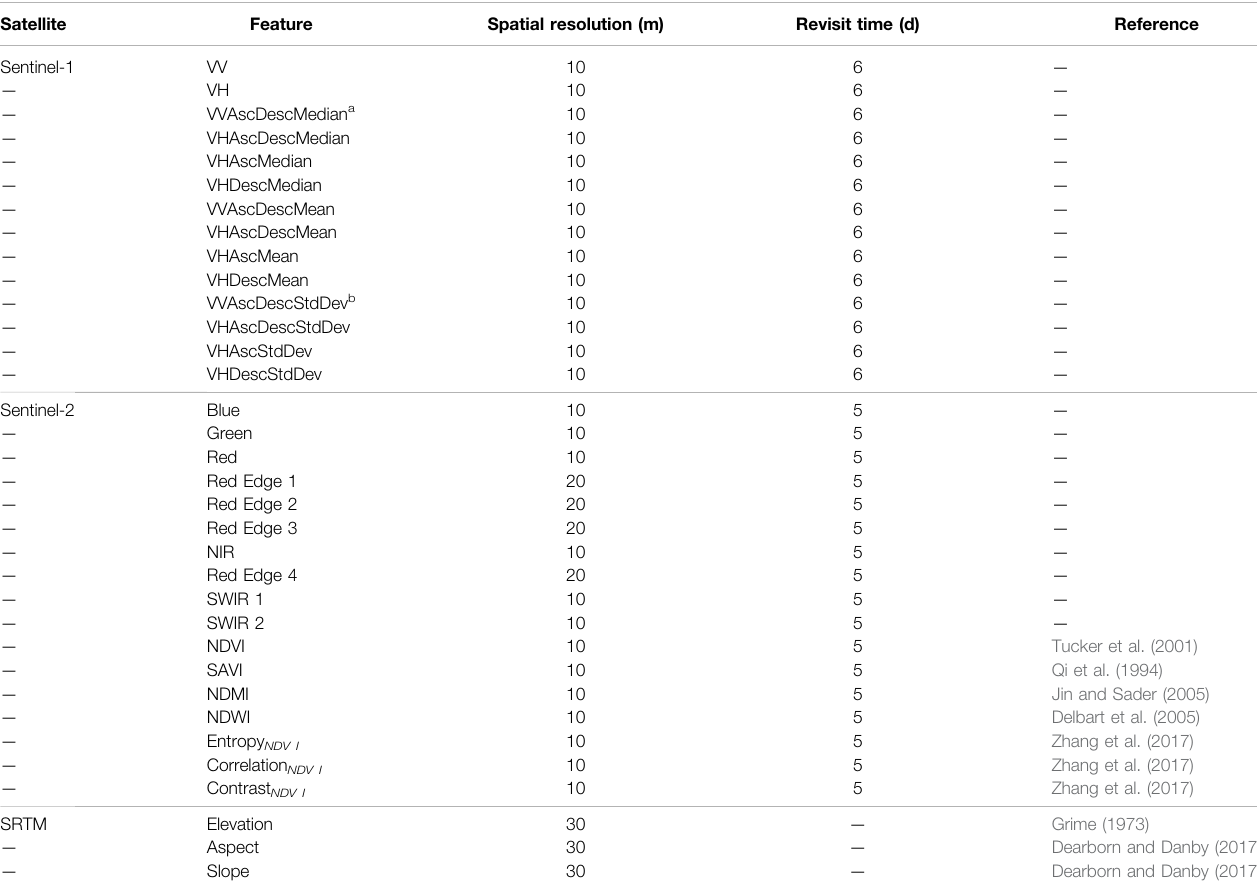
TABLE 1 | Major information of multifeatures selected in Sentinel-1, Sentinel-2, and Shuttle Radar Topography Mission (SRTM).